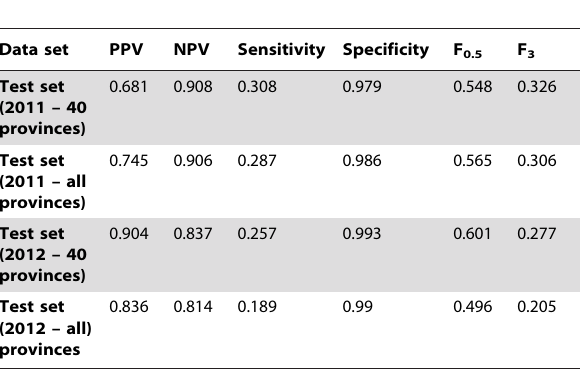
Table 6. Seasonal moving average prediction results for Philippines.